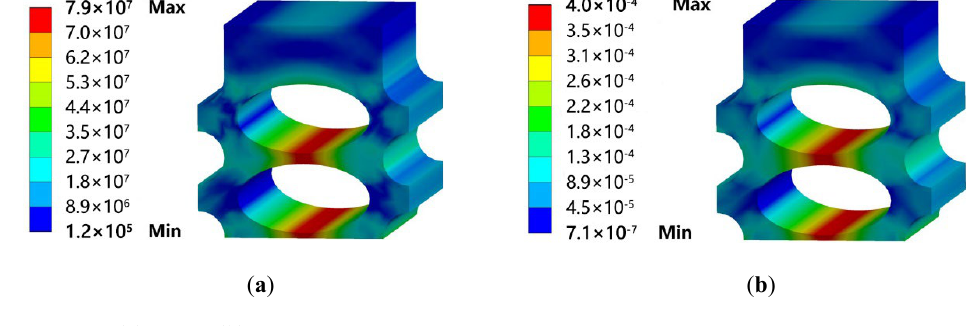
Figure 3. ( a ) Stress; ( b )